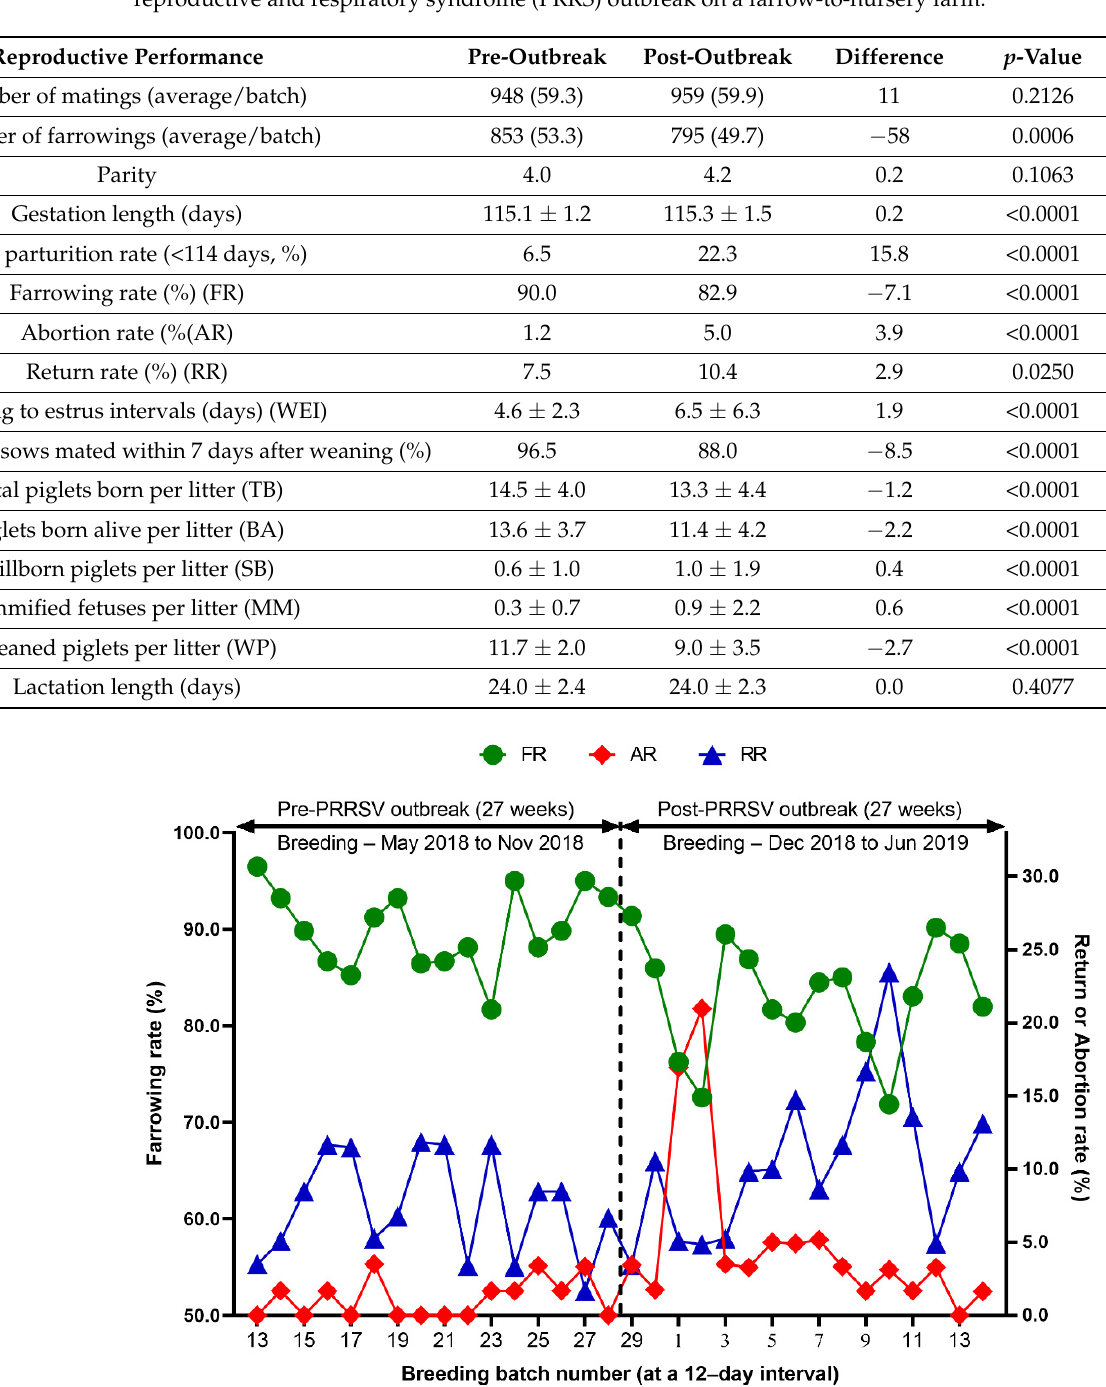
Figure 4. Comparison of total piglets born per litter (TB), piglets born alive per litter (BA), and weaned piglets per litter (WP) before and after a PRRS outbreak.